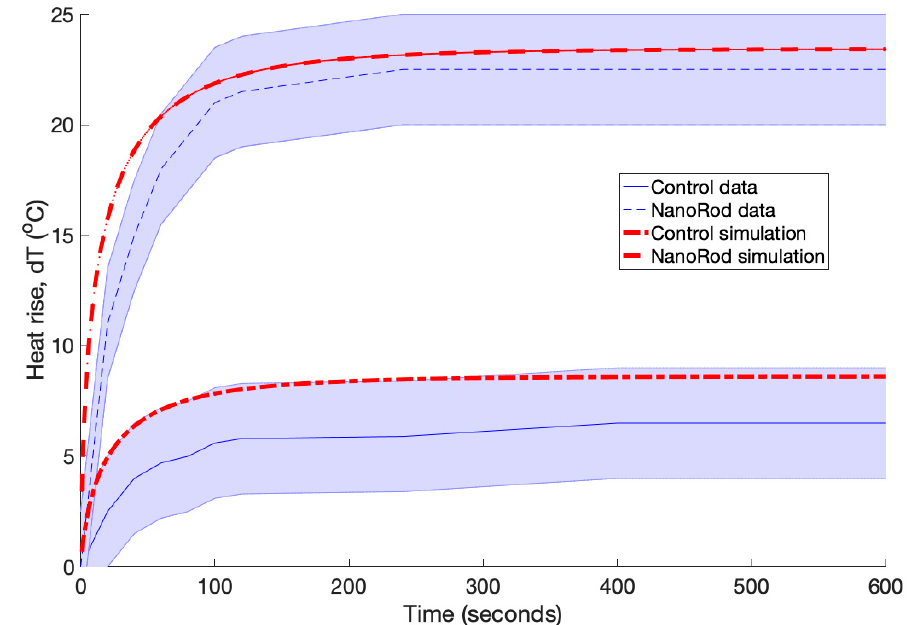
Figure 4. Shows heat rise ( ° C) in the centre of tumour over 10 min (600 s) comparing simulations to experimental data taken from Dickerson et al. [22]. In their experiment, treatments were performed by administration of 15 µL of pegylated gold nanorods (OD 800 = 40, 2 min accumulation) followed